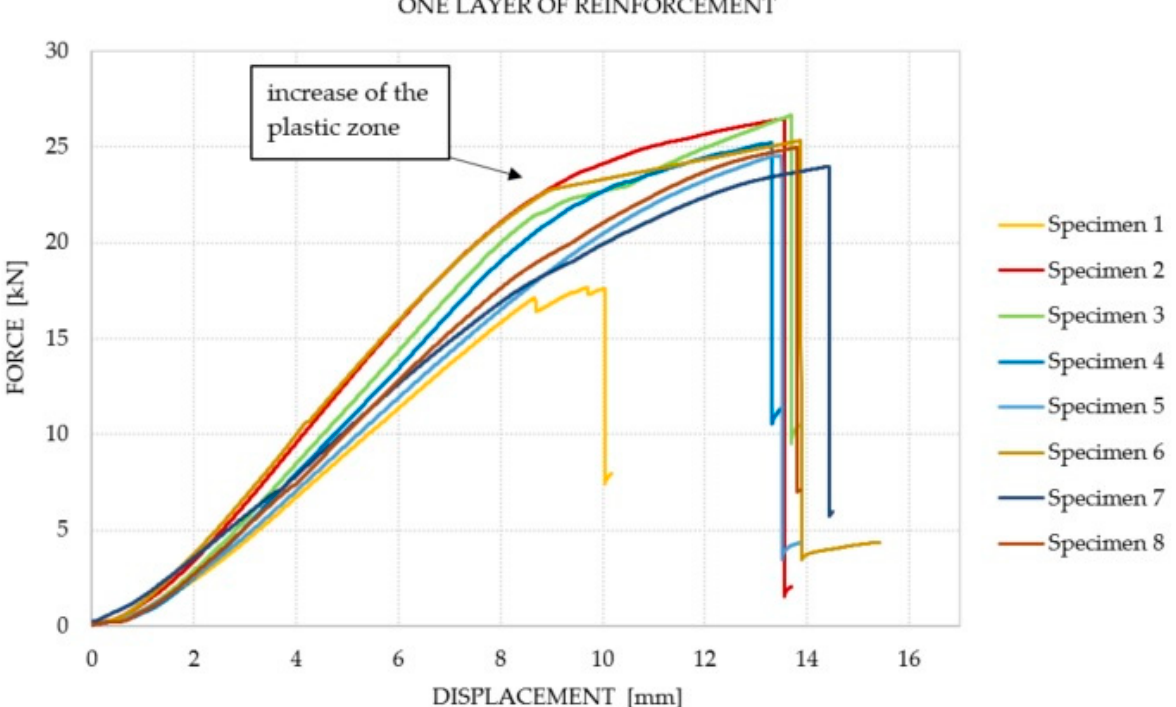
Figure 8. Force–displacement chart for the beams with one layer of reinforcement.